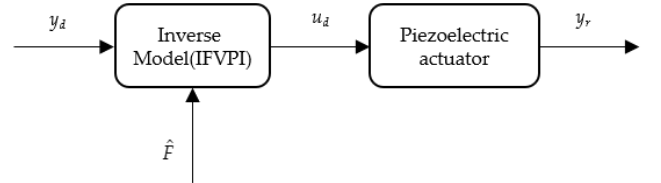
Figure 12. Schematic diagram of IFVPI feedforward control.